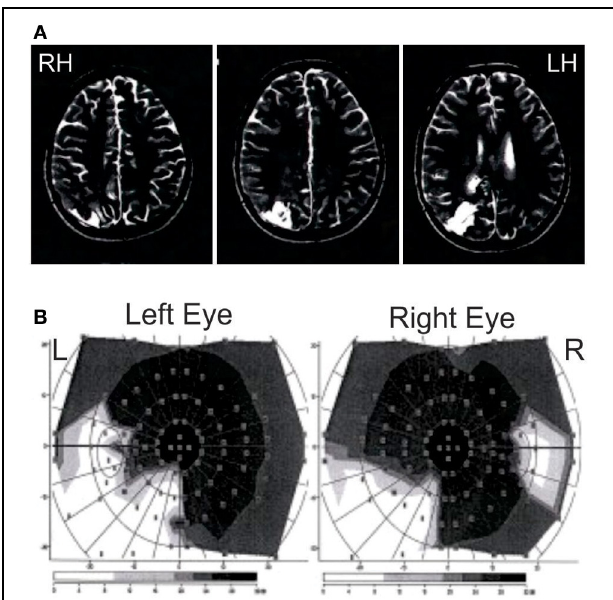
FIGURE 1 | Patient JG MRI and visual perimetry. (A) MRI of patient JG. T2-weighted scans showing the damage after cyst removal (in white lower left) at the right parieto-occipital junction, including the caudal part of the intra-parietal sulcus and extending subcortically to the right lateral ventricle through the white matter. Scans are shown in radiological convention. (B) Goldman perimetry showing patient’s quadrantanopia in the lower left visual field. She also showed somewhat large blind spots in both eyes.